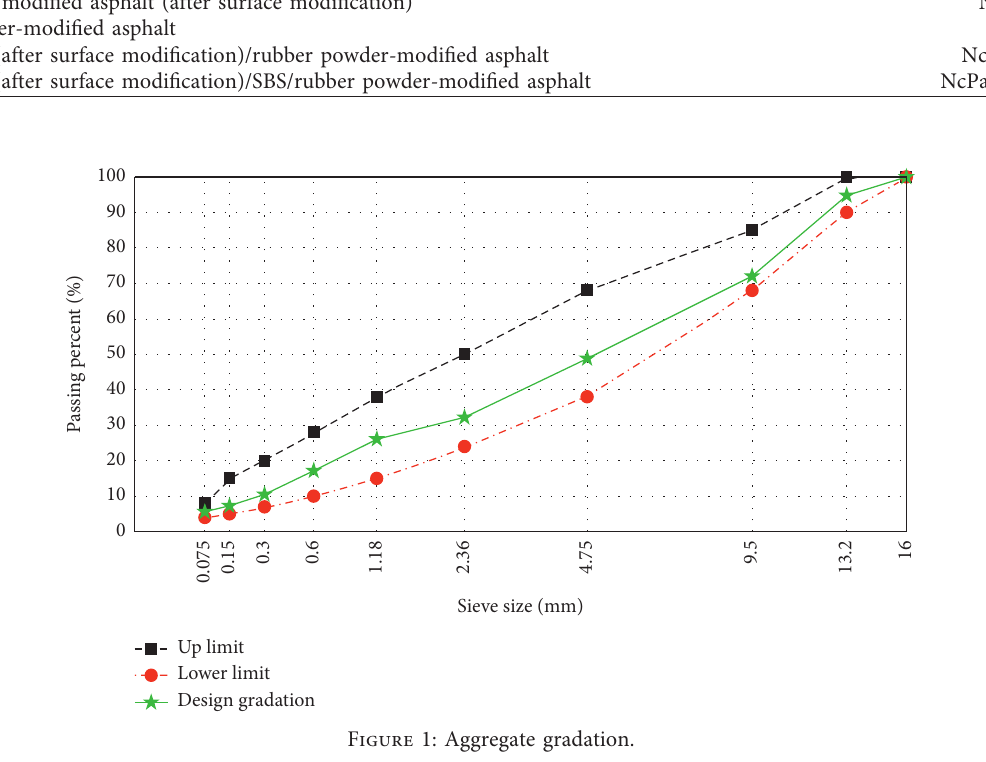
Figure 1: Aggregate gradation.